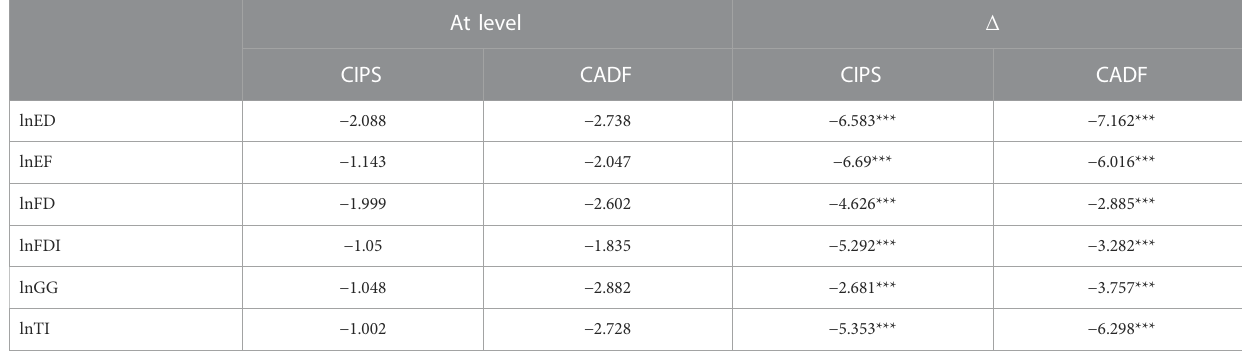
TABLE 8 Results of PURT.